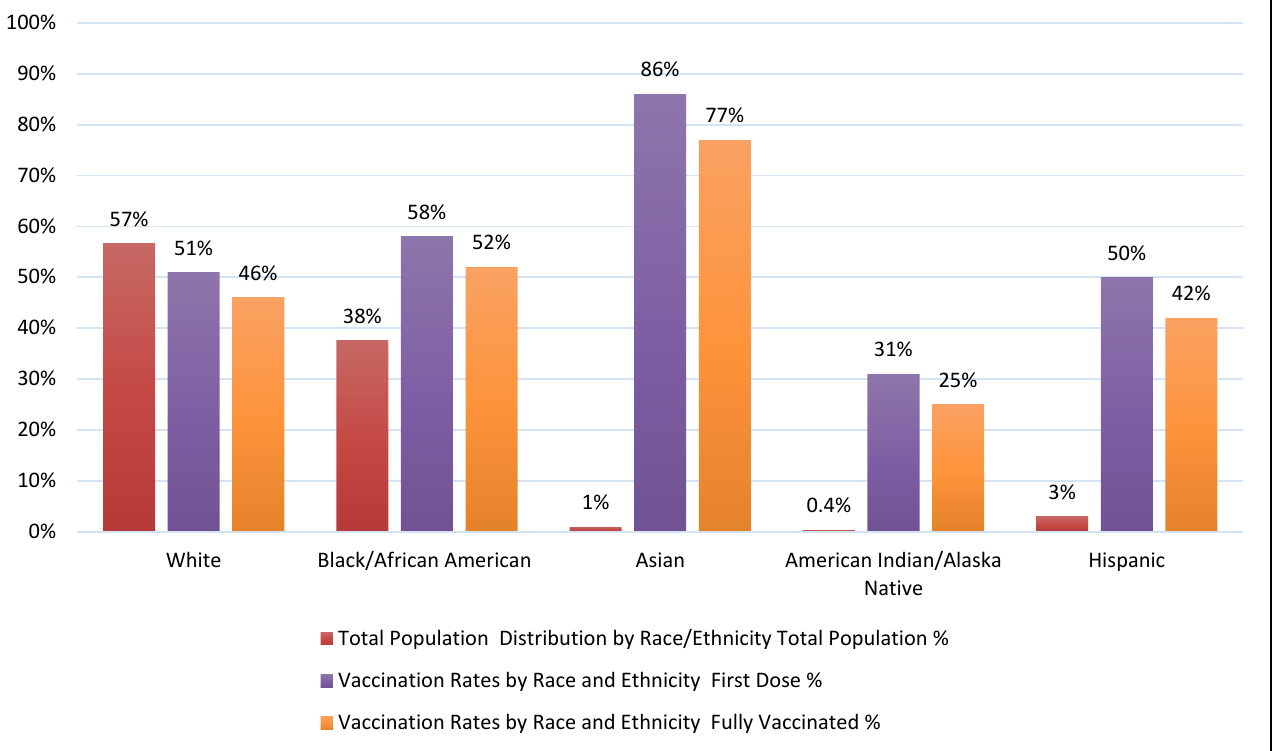
Figure 1. Vaccination administration amongst the Mississippi population based on race and ethnicity. Notes: Population and demographic data are based on the Census Bureau’s American Community Survey (ACS) analysis and may differ from other population estimates published yearly by the Census Bureau. US Mississippi state vaccination data were obtained from the Mississippi State Department of Health website. The vaccination data included one dose and a fully vaccinated percentage. Native Hawaiian or Other Pacific Islander, two or more races, unknown races, and Unknown ethnicity peoples are excluded from the chart.